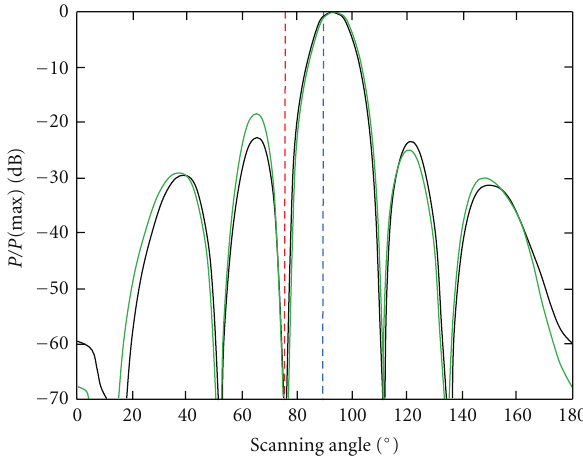
Figure 16: The beam pattern of the antenna array with 75 degrees of interference.